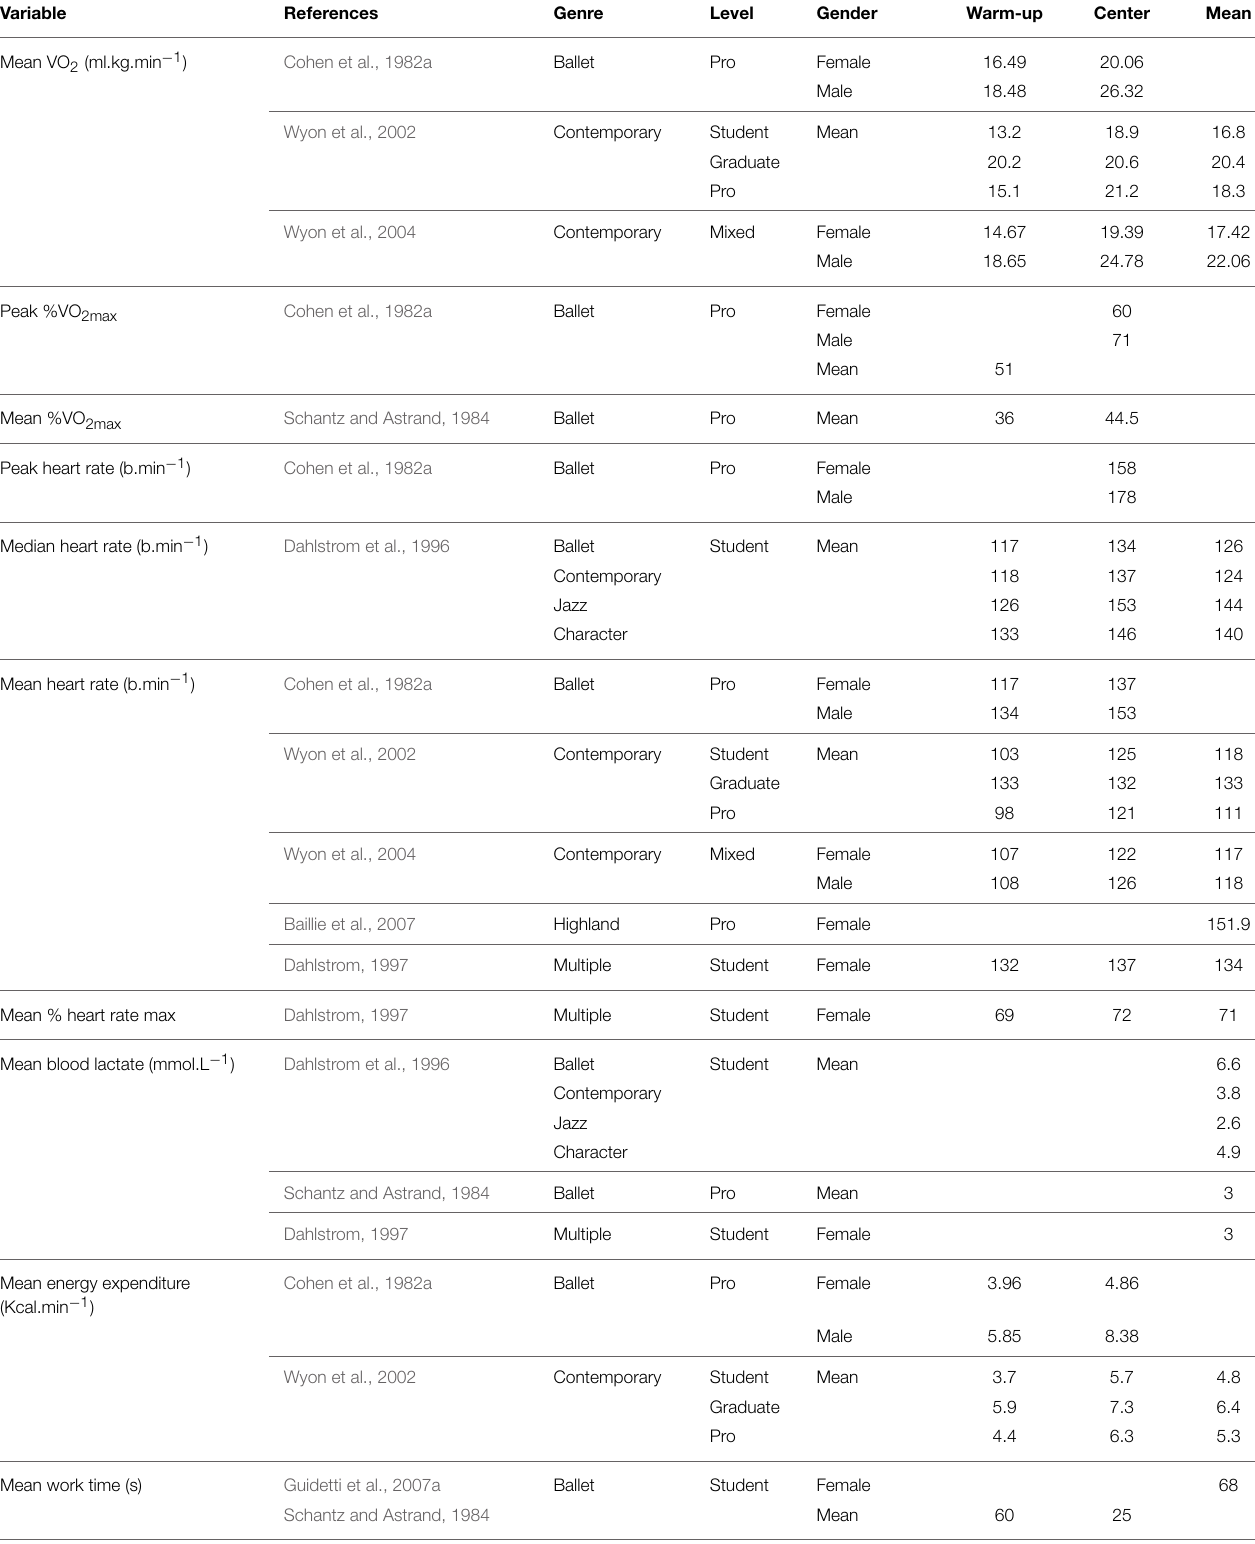
TABLE 1 | Mean data of studies examining the energy demand of dance class.